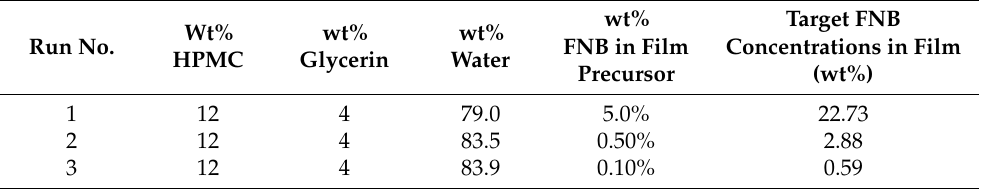
Table 1. Composition of the precursor suspensions and target FNB concentrations in the dried film.